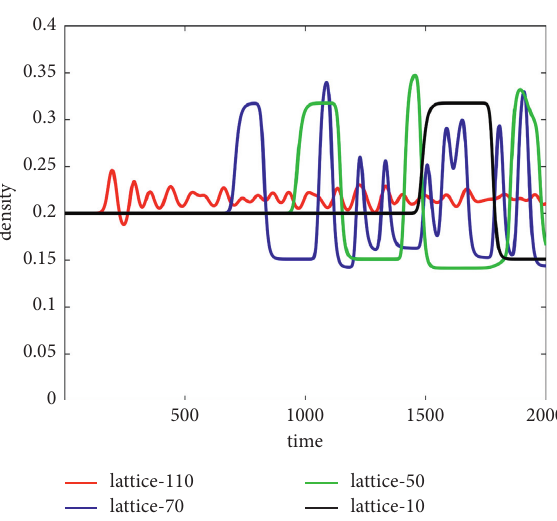
Figure 2: Density evolution diagram.